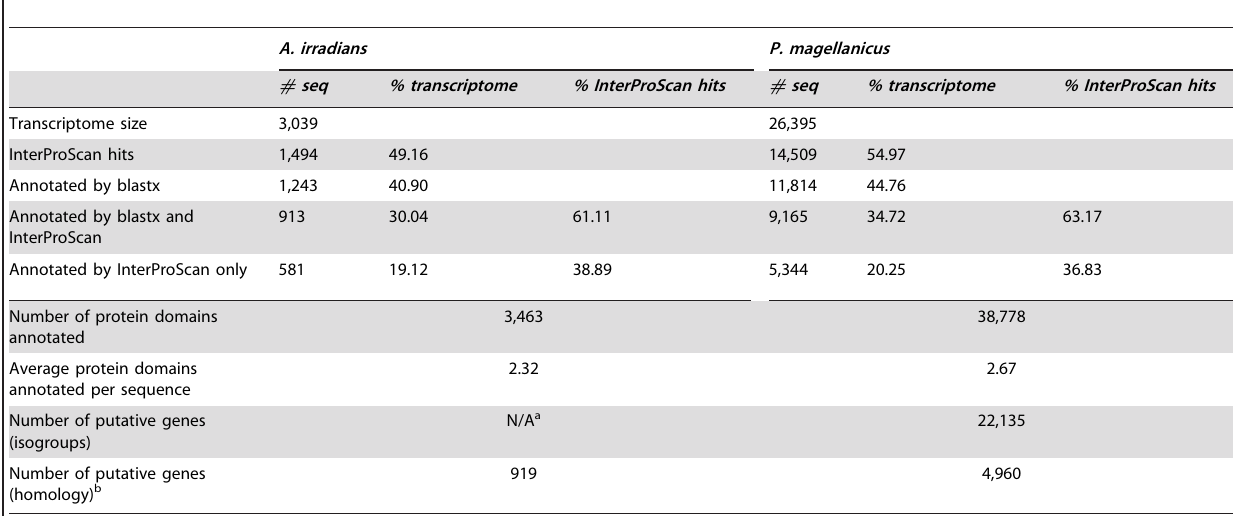
Table 3. Protein domain annotation of A. irradians and P. magellanicus adult eye